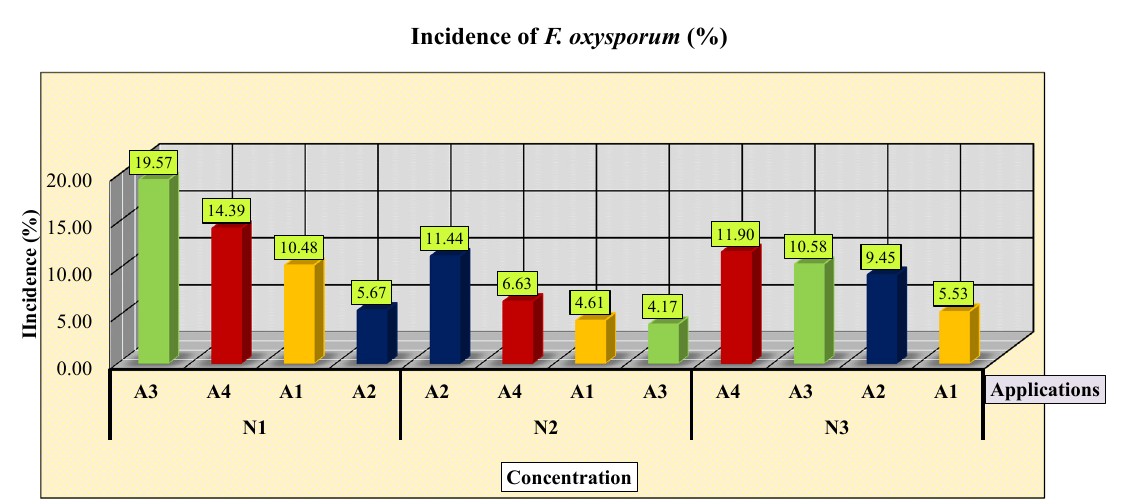
Figure 1. Simple effects on incidence of Fusarium oxysporum (%) at 70 days after transplant, Irrigation of Santa Rita–Arequipa, 2016 Table 5. Simple and main effect of concentration and number of applications on the incidence and AUDPC of Fusarium oxys- porum (%) at 70 (ddt), Irrigation of Santa Rita–Arequipa,